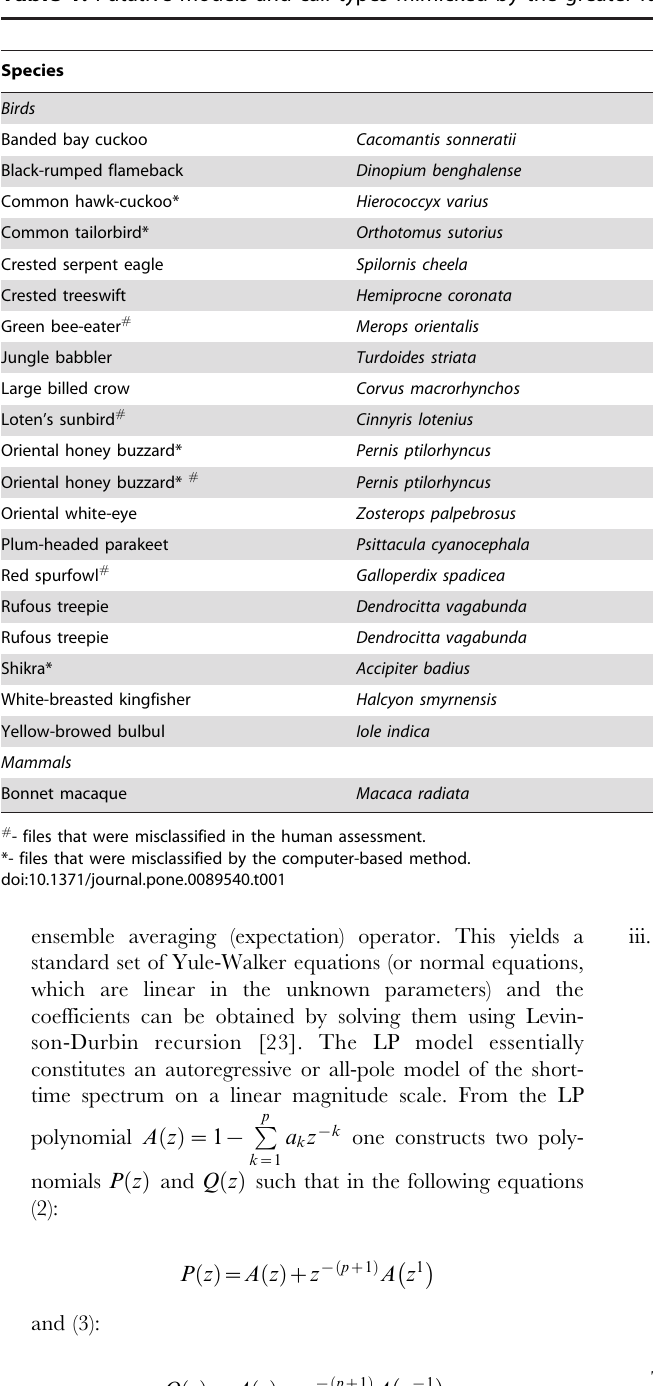
Table 1. Putative models and call types mimicked by the greater racket-tailed